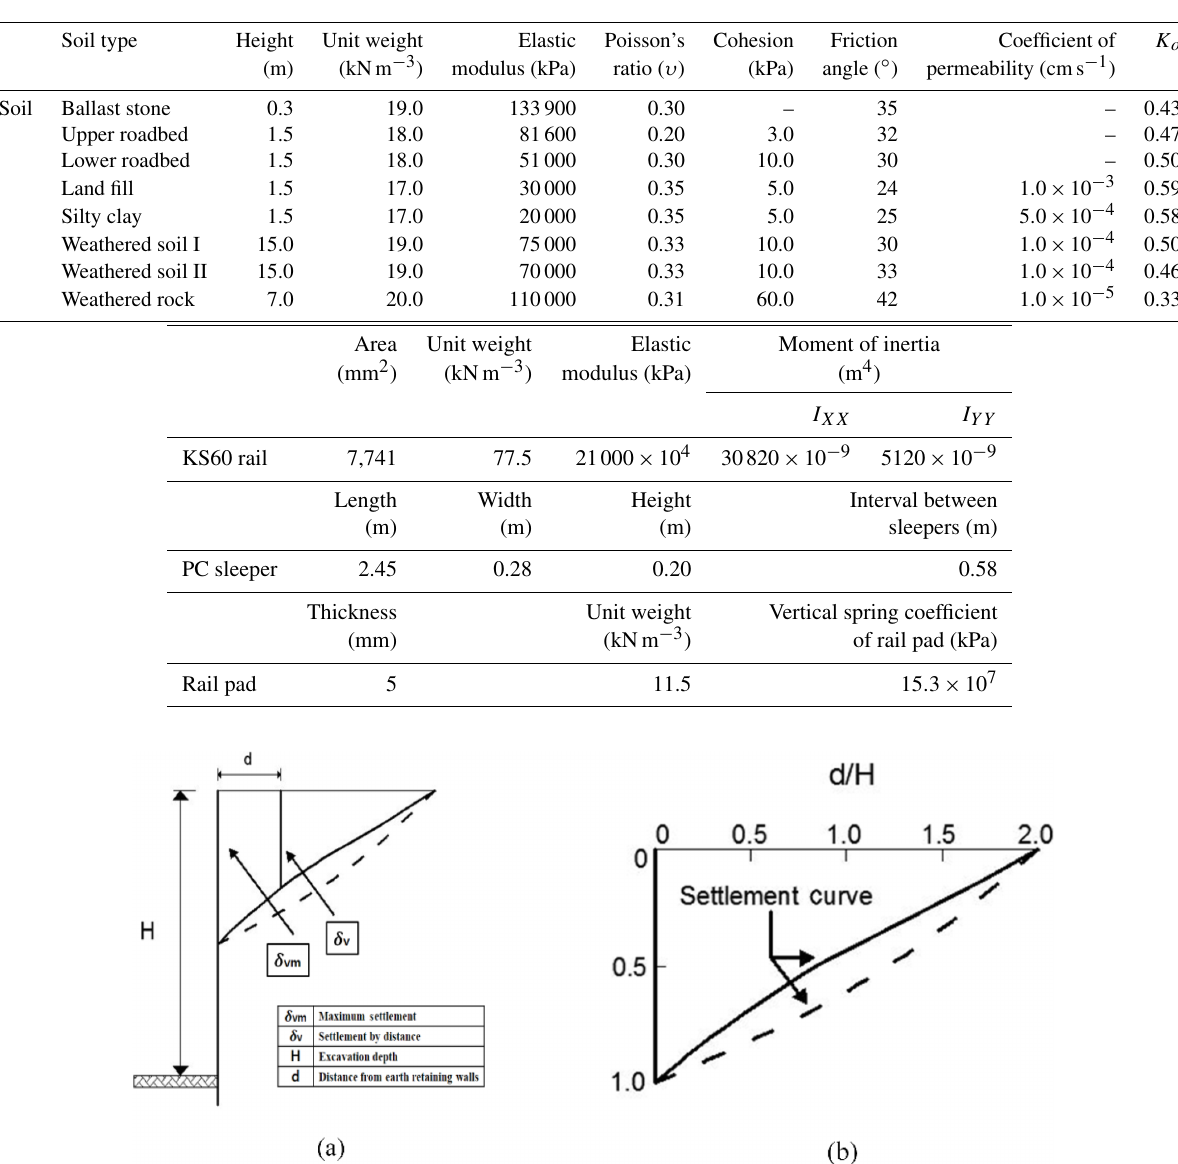
Table 1. Physical properties of soil, rail, PC sleeper and the rail pad.